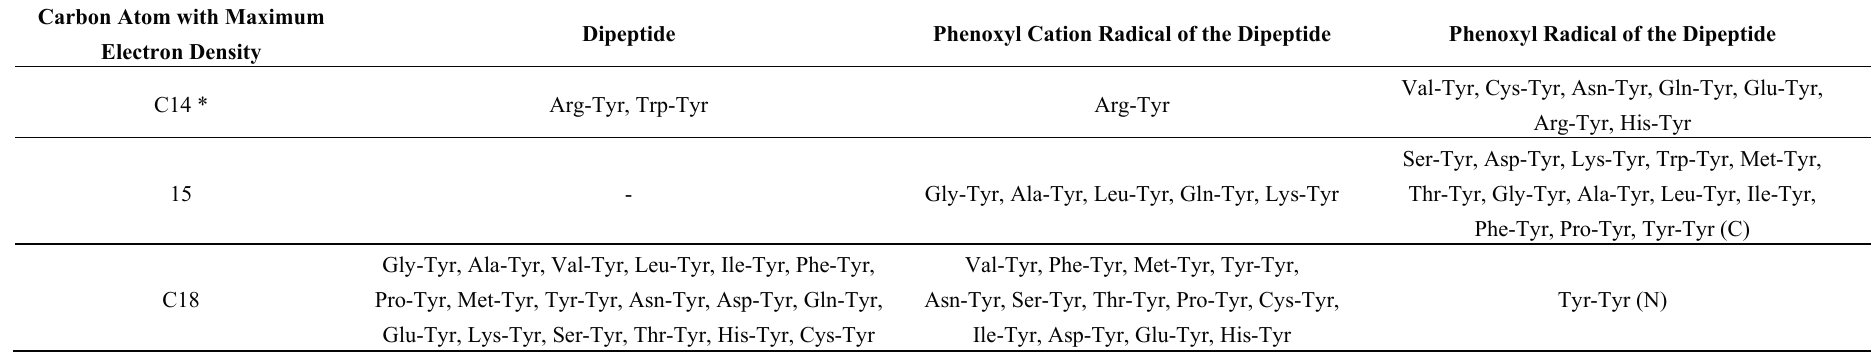
Table 9. Carbon atoms with maximum electron density in C-terminal tyrosine dipeptides and the corresponding radicals and cation radicals. Carbon Atom with